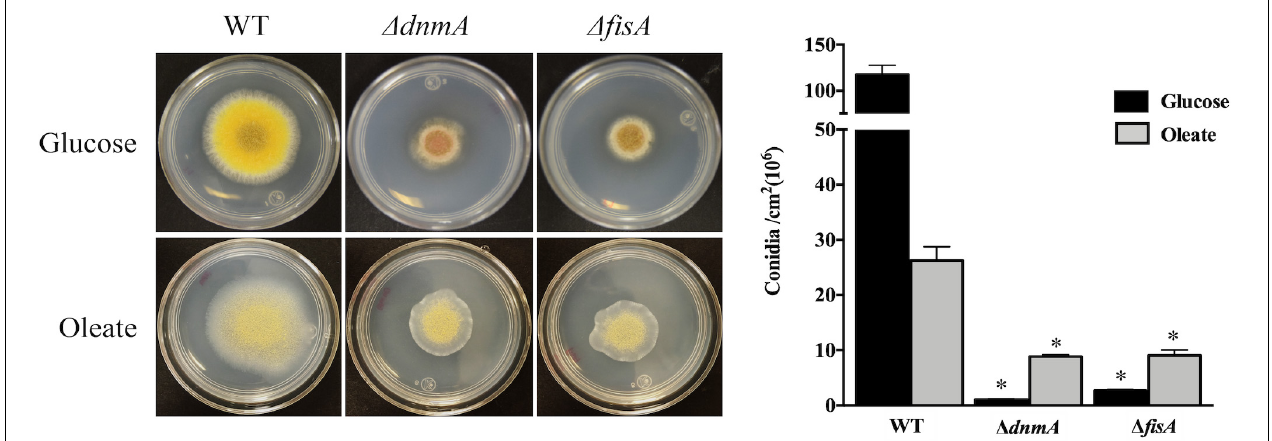
FIGURE 5 | Growth and asexual sporulation of (cid:49) dnmA and (cid:49) fisA mutants are improved in oleate as sole carbon source. Conidia from strains RPA (WT), CVG30 ( (cid:49) dnmA ), and CVG31 ( (cid:49) fisA ) were inoculated on supplement MM plates containing either glucose or oleate as sole carbon source and incubated at 37 ◦ C for 3 days and photographed (Left) and conidia per square centimeter were determined (Right) . Bars indicate standard deviation from three independent experiments. Data analyzed by one-way ANOVA, following Tukey’s test ( ∗ p < 0.05). Asterisks indicate significant differences with respect to the WT strain.